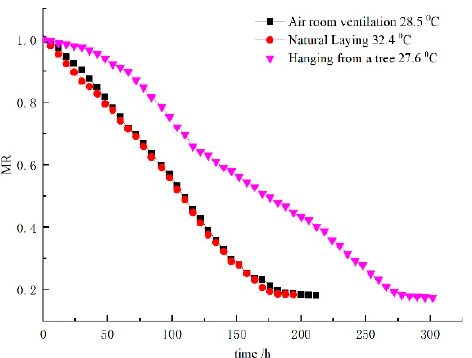
Figure 3. Change in water ratio of apricots under different drying conditions.